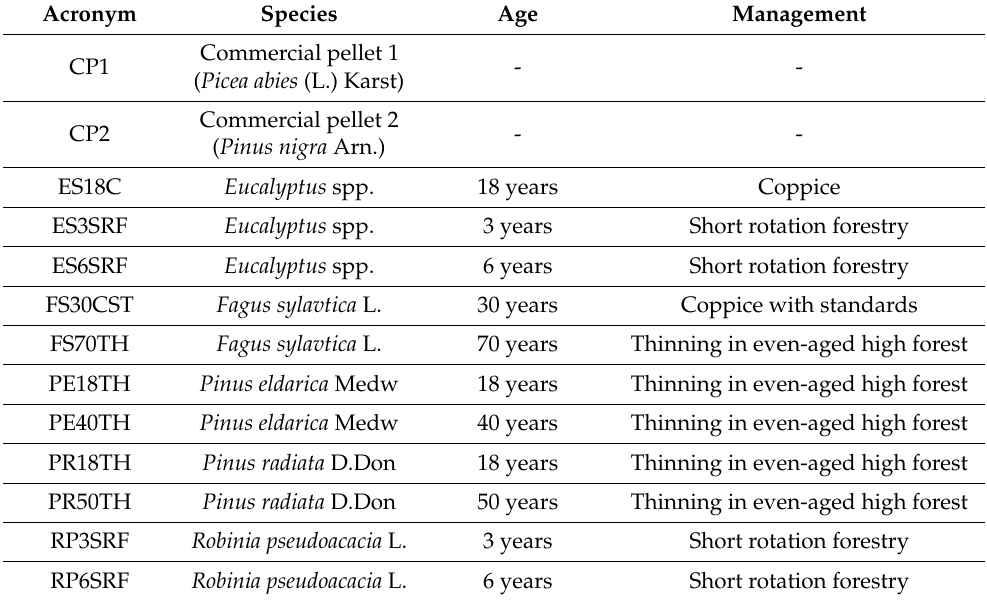
Table 1. Different types of wood material used for pellet production.